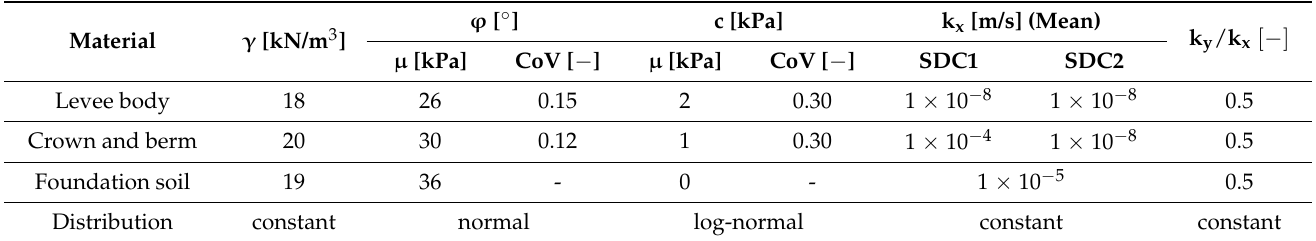
Table 1. Parameters and the statistics used for slope stability